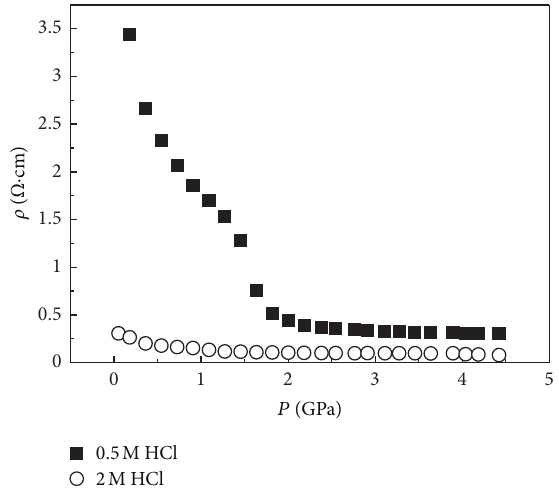
Figure 4: Effect of concentrations of HCl on resistivity of PAN under high